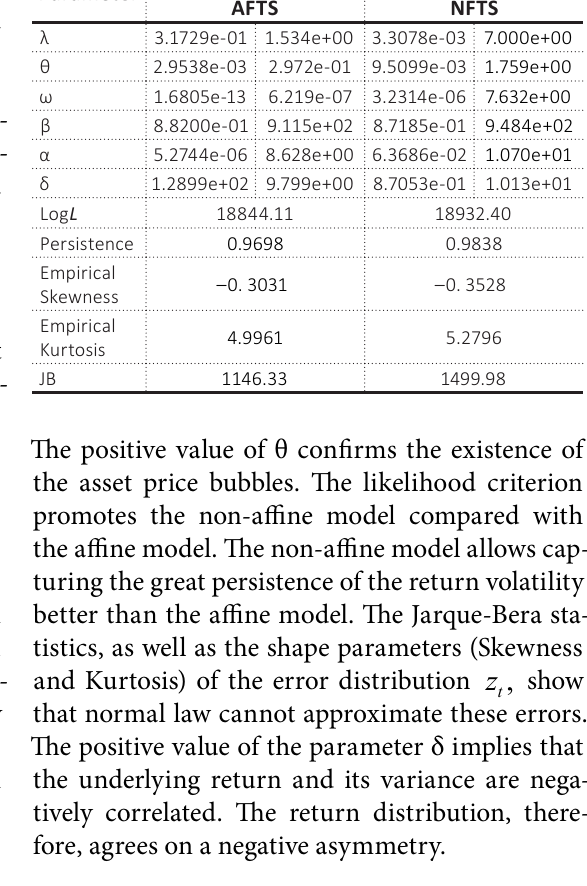
Table 1. Estimations and properties (daily returns of CAC 40 from January 1988 to December 2012) Parameter